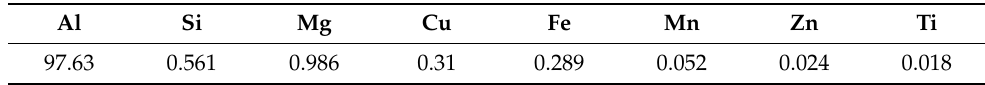
Table 1. Chemical composition of aluminum alloy 6061 (wt.%) [24].